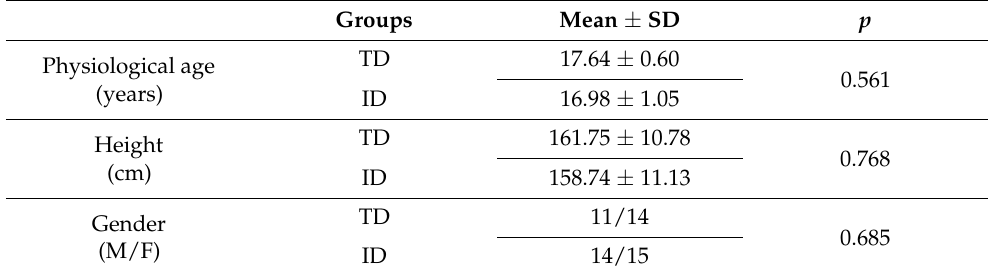
Table 2. Participants’ Demographics.